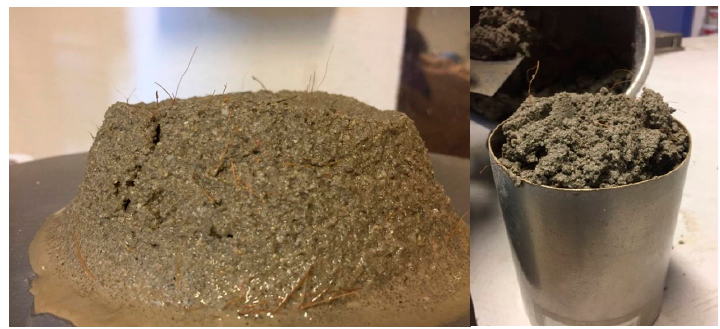
Figure 4. Flow table and bulk density test for coir fiber-reinforced cement mortar.